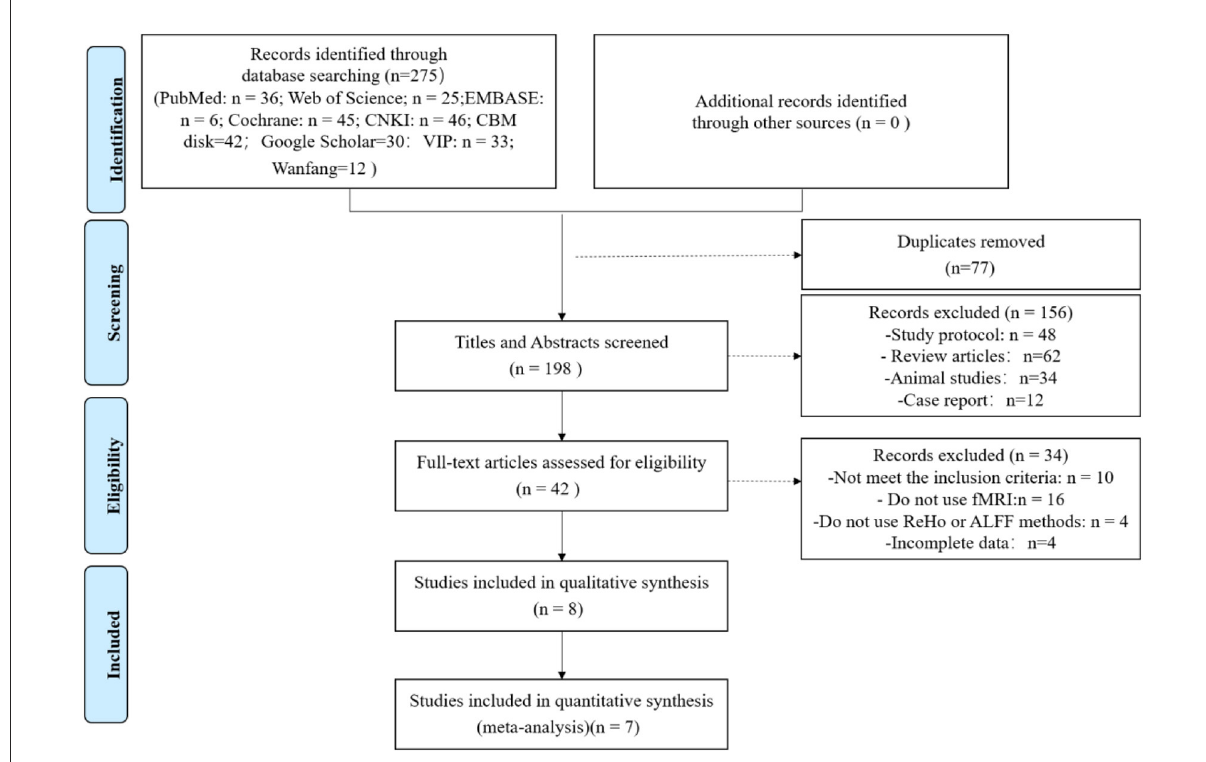
FIGURE1 Flowchart of literature